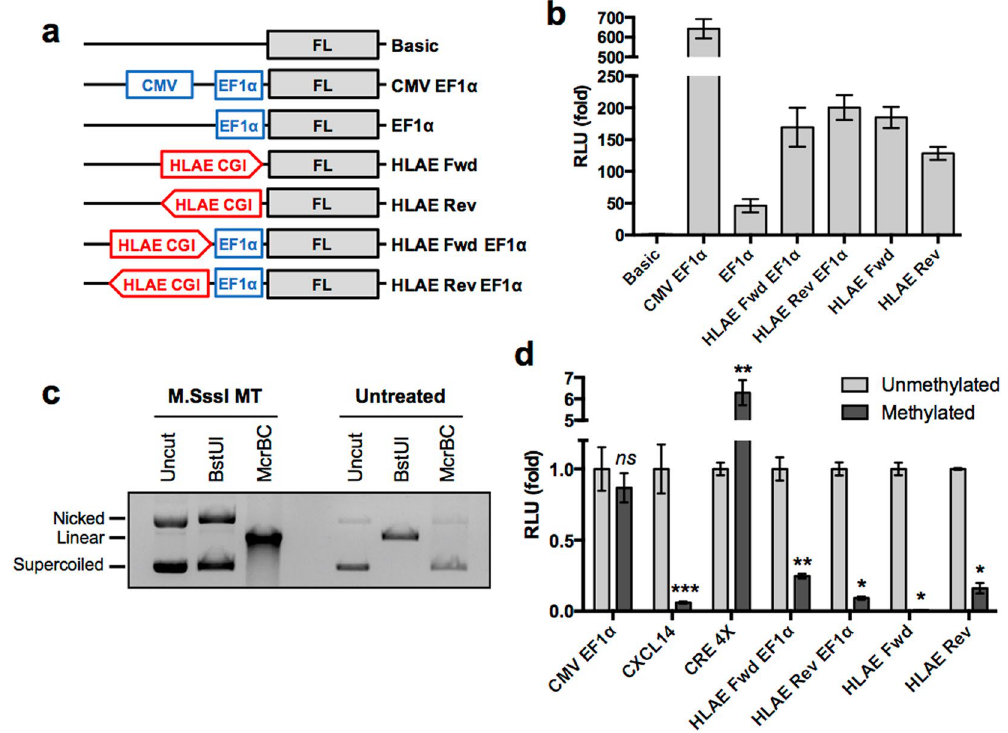
Figure 5. Promoter activity of the HLA-E CGI is repressed by DNA methylation. ( a ) Schematic representation of pCpGL plasmid constructs. The HLA-E CGI (HLAE CGI) was directionally cloned into pCpGL constructs indicated by an arrow head at the 3 ′ end. ( b ) 293FT cells were transfected with indicated pCpGL constructs (panel a ) along with a Renilla luciferase (RL) plasmid as a transfection control. Luciferase activity was measured 24 hours post transfection using the Dual Luciferase Reporter Assay (Promega). Representative data of three independent experiments is shown as a fold ratio (firefly luciferase, FL/RL) of relative light units (RLU) from quadruplicates. ( c ) The pCpGL plasmid containing the CXCL14 promoter element was incubated with M.SssI methyltransferase (MT) or buffer only (untreated). Samples were subsequently treated with buffer only (uncut), BstUI (cut unmethylated DNA) or McrBC (cut methylated DNA) methylation-sensitive endonucleases. Samples were separated in 0.7% agarose gel to verify in vitro methylation. ( d ) 293FT cells were transfected with M.SssI MT-treated (methylated) or buffer only control (unmethylated) pCpGL reporter constructs (described in panel a ) along with an RL plasmid as a transfection control. Luciferase activity was assessed. Fold changes to the unmethylated reporter constructs are plotted. Shown are representative data of four to five repeats. P -values were calculated by Student’s t test. * p < 0.0005, ** p < 0.005, *** p =